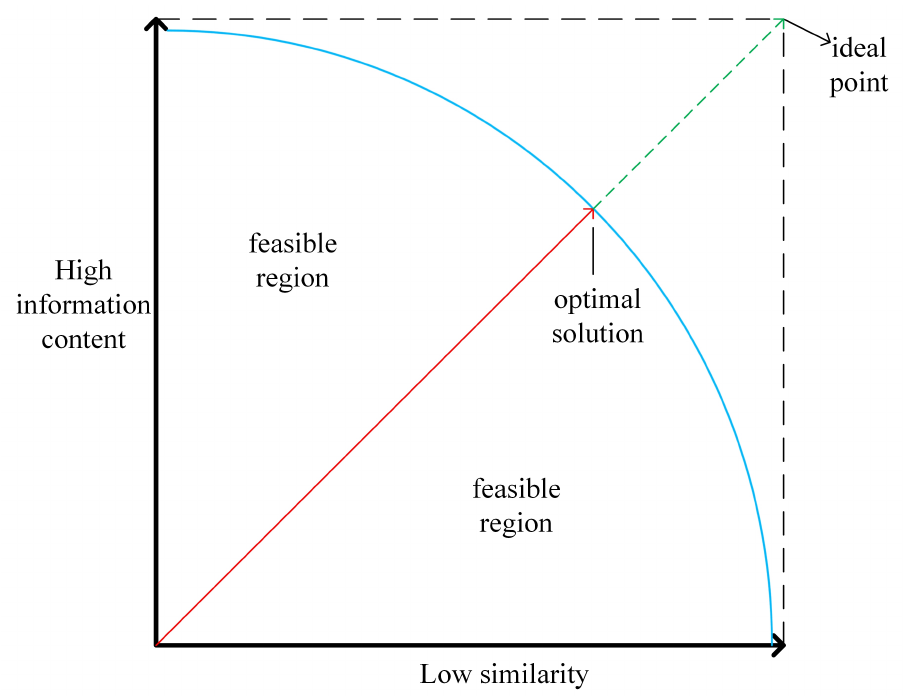
Figure 1. The description of the